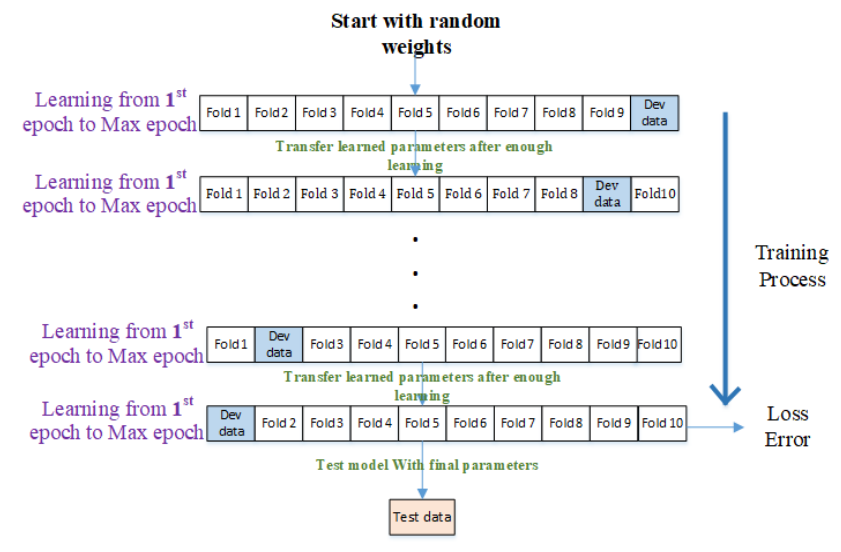
Fig. 4. Schematic illustration of the SK-Fold CV method for the model